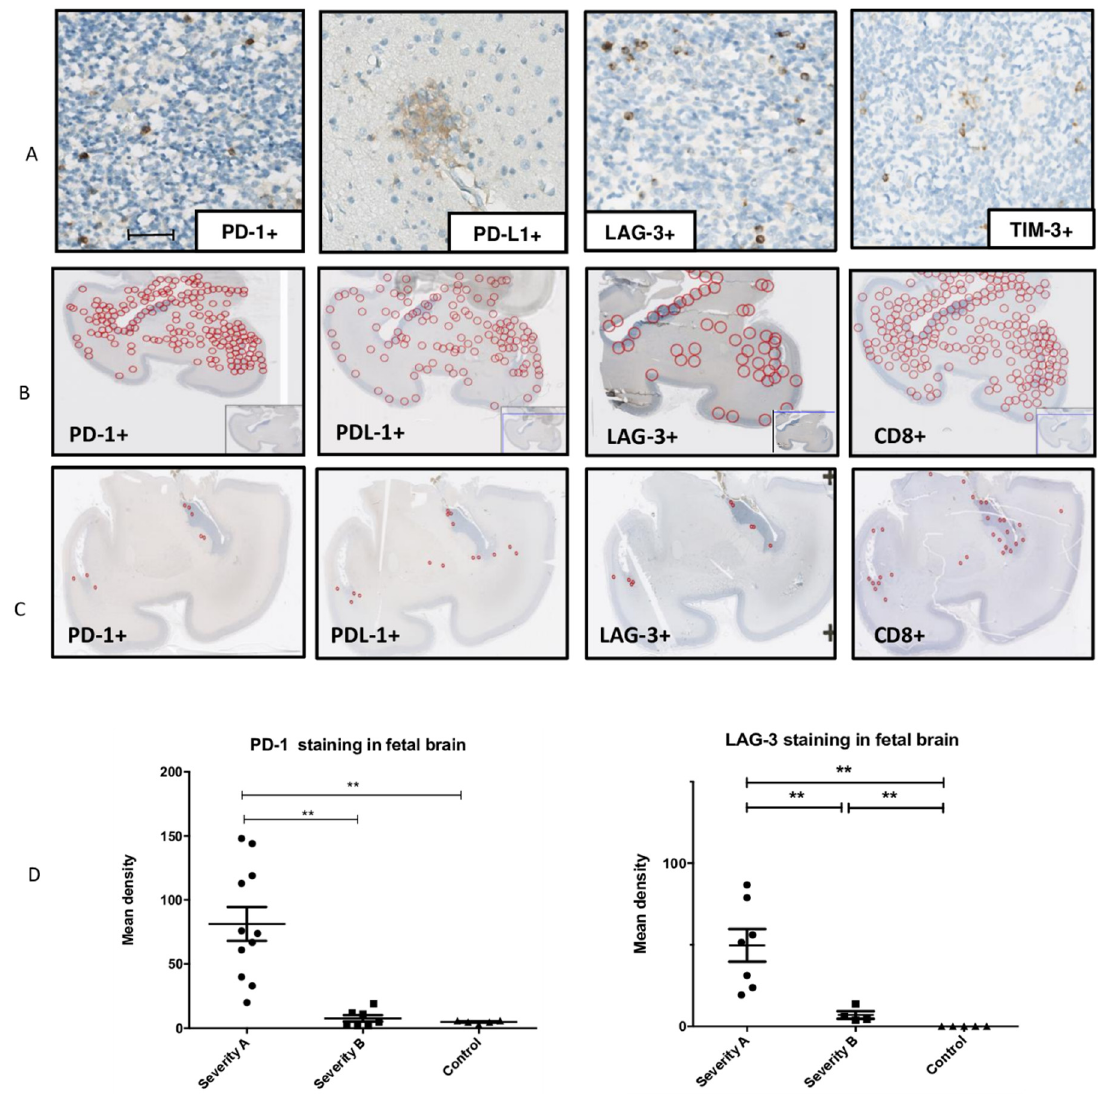
Figure 4. Detection, localization, and quantification of PD-1 + cells, PD-L1 + cells, LAG-3 + cells, and TIM-3 + cells in infected fetal brains. ( A ) Detection of PD-1, PDL-1, LAG-3, and TIM-3 immunostaining in one of the severely a ff ected brains (case 7), scale bar 50 µ m. ( B ) Localization of PD-1, PDL-1, LAG-3, and CD8 immunostaining in one of the severely a ff ected brain samples and ( C ) in a moderate a ff ected brain sample. ( D ) Mean immunostaining densities of PD-1 and LAG-3 according to the severity of the brain lesions: severe (group A), moderate (group B), and controls; ** p < 0.01, *** p < 0.001. Kruskal–Wallis test was used with Dunn’s Multiple Comparison’s Test and Mann–Whitney test.